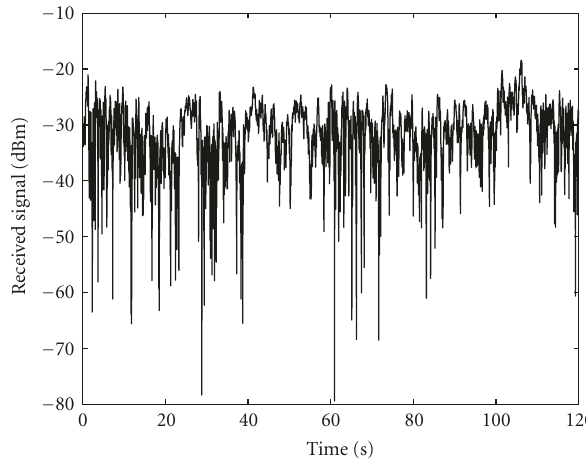
Figure 4: Typical measured signal at 29GHz for leaved dry decidu- ous trees (Site 1) during high-wind speed conditions ( ≥ 4.5m/s). A sampling rate of 500Hz was used to collect the signal.